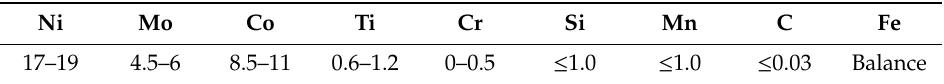
Table 2. Typical chemical composition ranges (wt%) of 18% Ni maraging steel 300 powders used in metal L-PBF